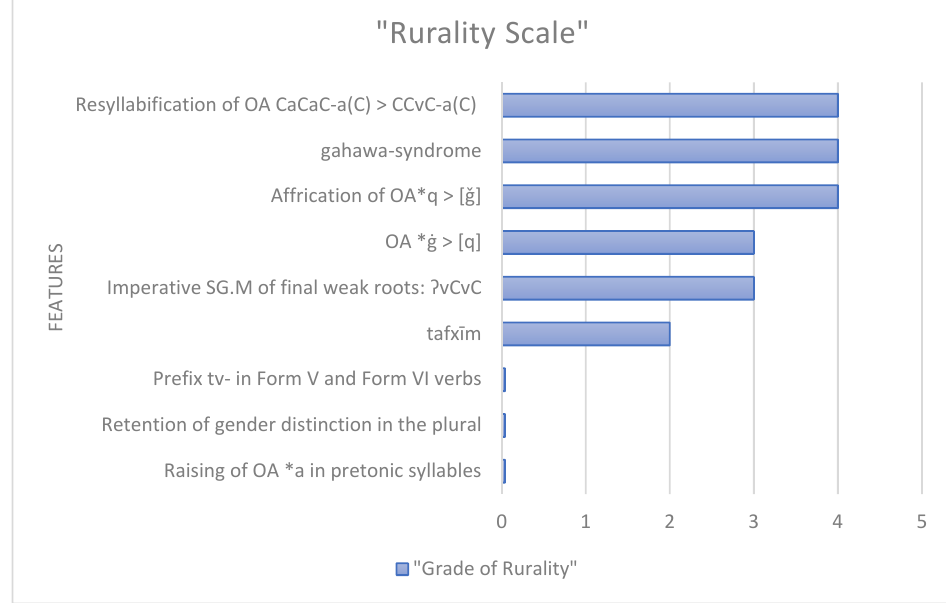
Figure 1. Scale of markedness of rural speech elements.